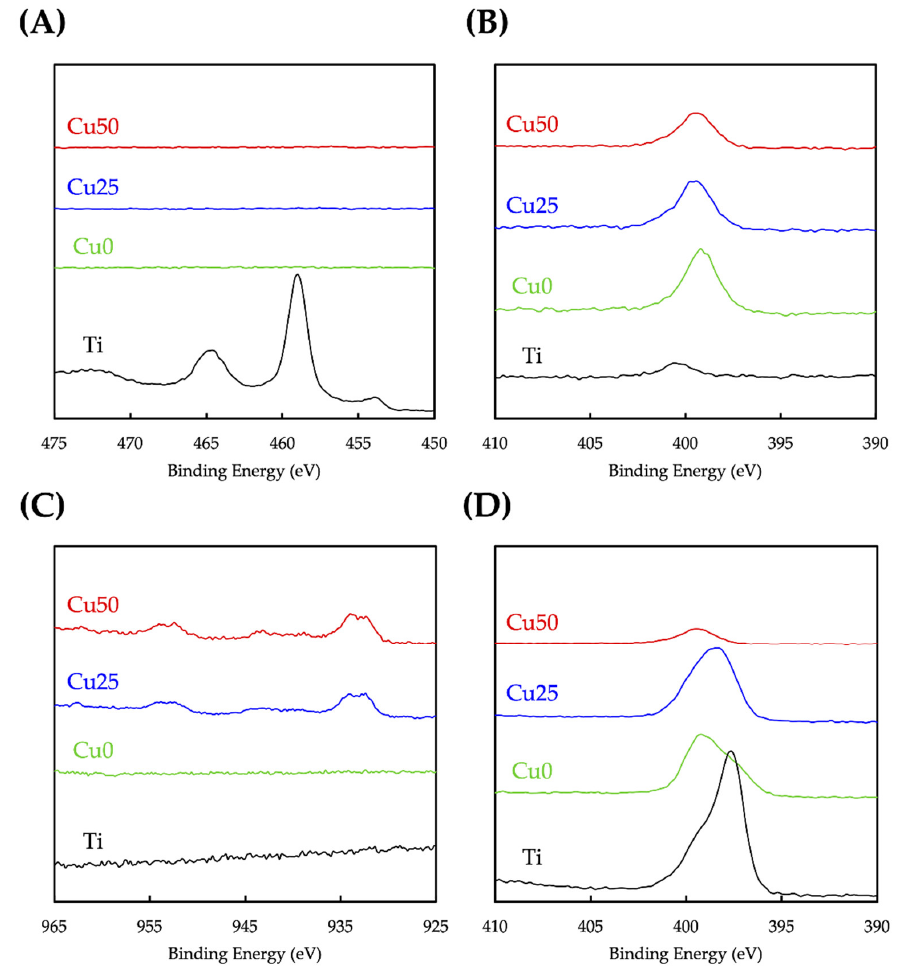
Figure 3. XPS spectra of ( A ) Ti, ( B ) N, ( C ) Cu, ( D ) O of the 3D-printed Ti6Al4V scaffolds before and after PDA/Cu coating.